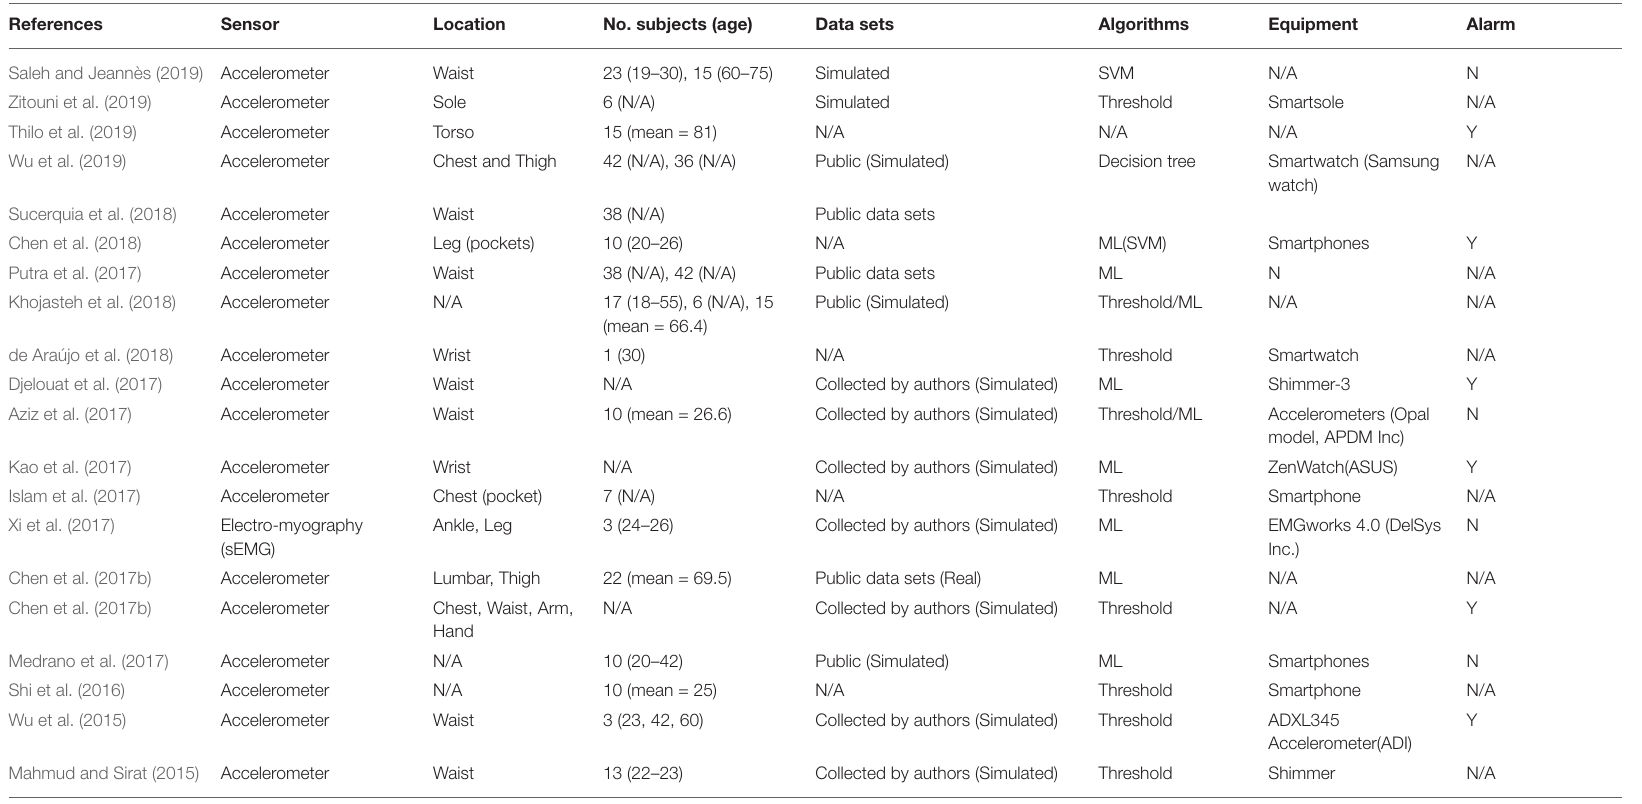
TABLE 3 | Fall detection using individual wearable devices from 2014 to